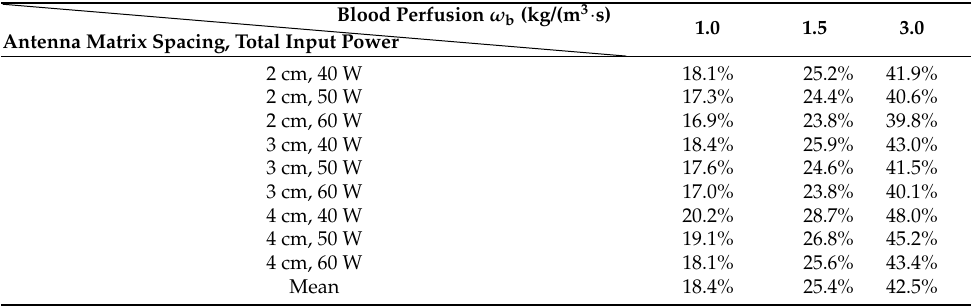
Table 5. Reduction in coagulation zone volume under three types of blood perfusion.